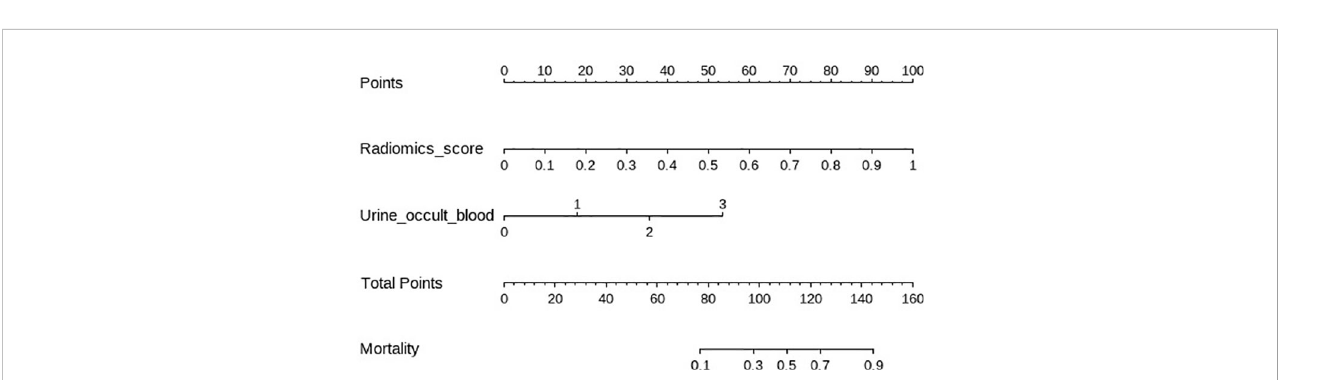
FIGURE 4 The clinical radiomics nomogram. The values of clinical characteristics and rad score can be converted into quantitative values according to the points axis. After summing the individual points to achieve the fi nal sum shown on the total points axis, The evaluation of this crescent is shown.